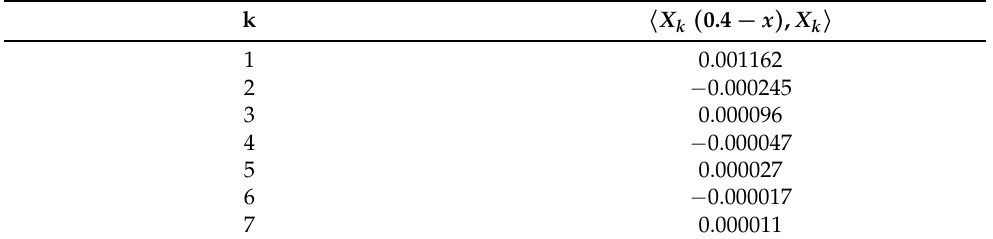
Table 2. The dot products values (cid:104) X k ( ℵ − x ) , X k (cid:105) at ℵ = 0.4; γ = 1.472; c =